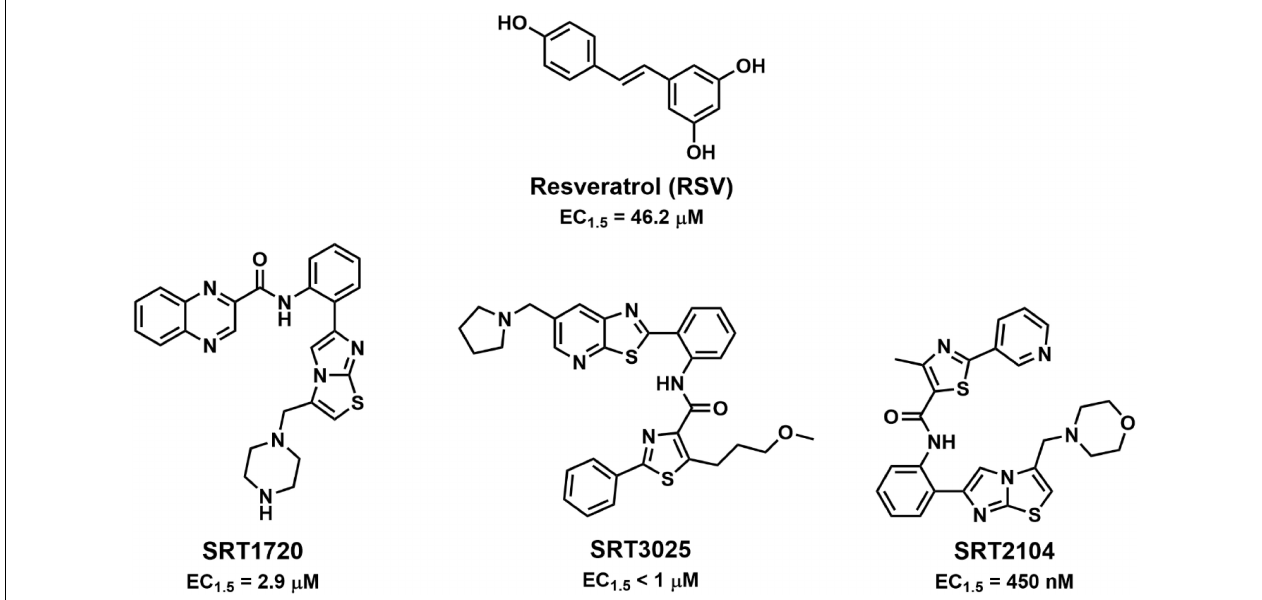
FIGURE 1 | Structures of resveratrol and the SRT family of SIRT1 activators.